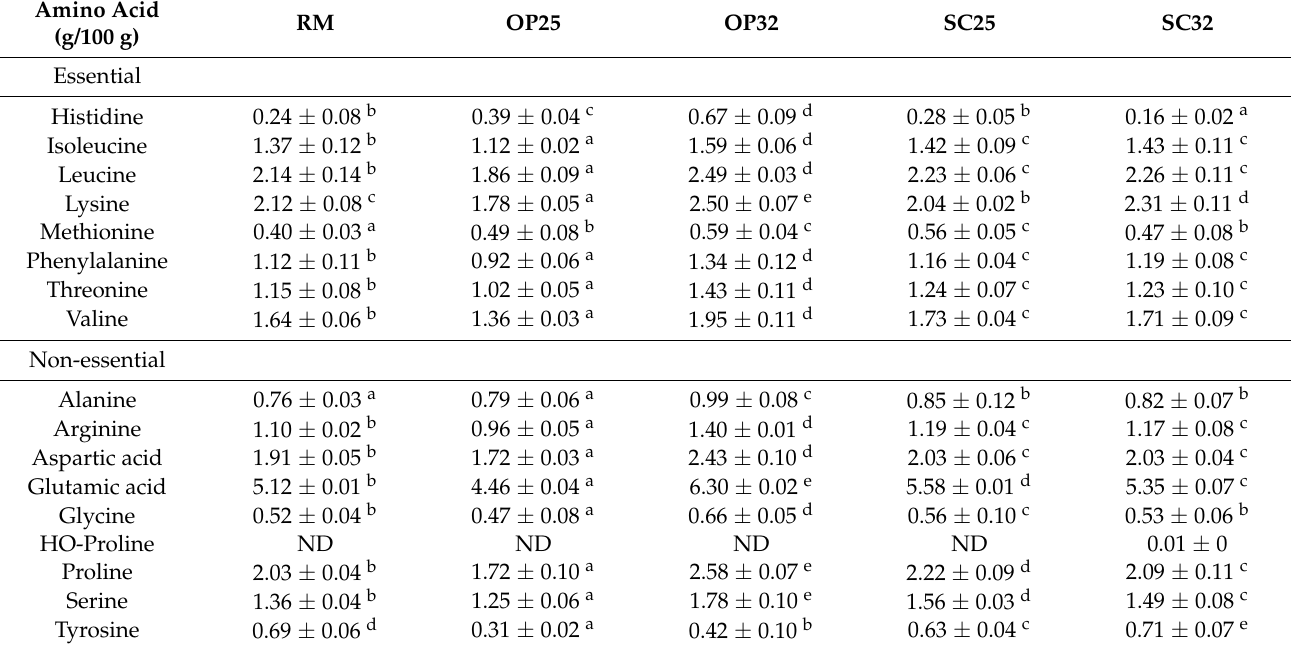
Table 2. Amino acid contents of raw milk and